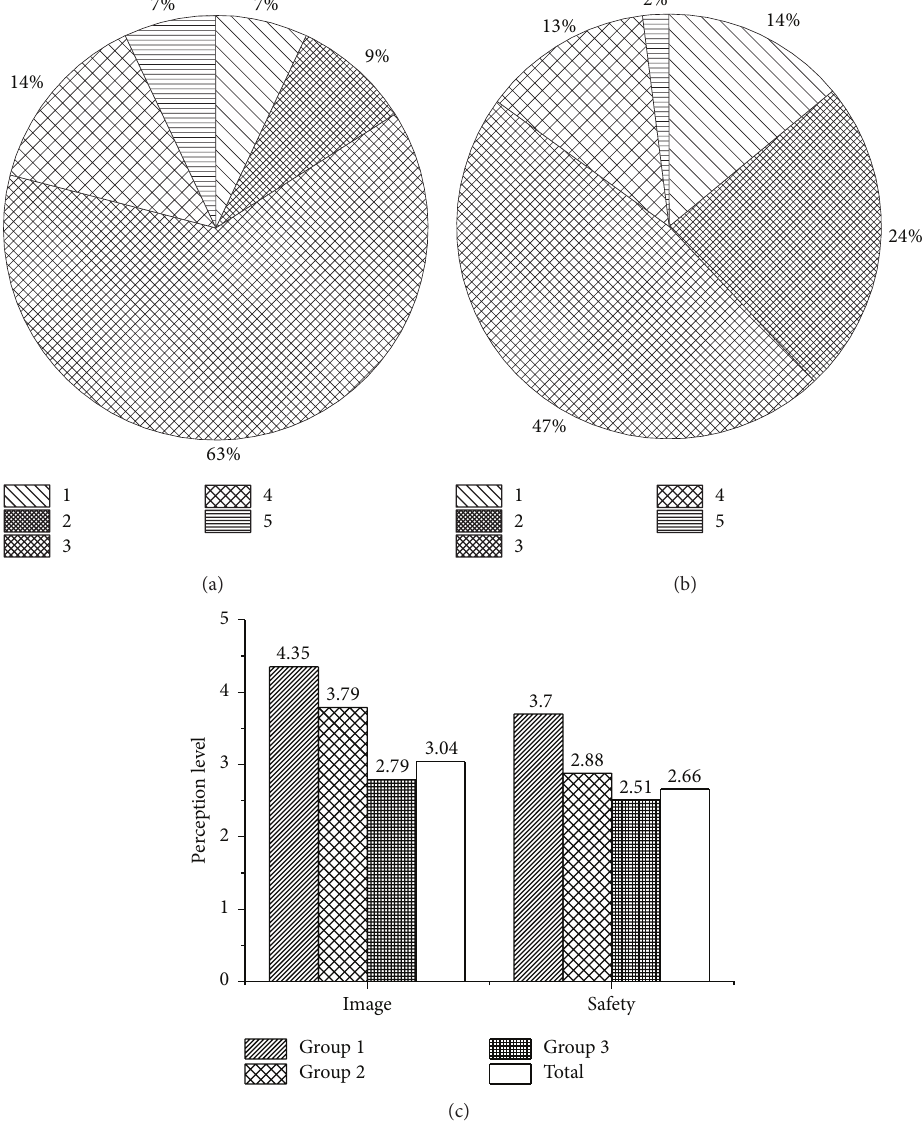
Figure 2: (a) Image level responses from 1 = very bad image to 5 = very good image, (b) safety level responses from 1 = highly unsafe to 5 = highly safe, and (c) average levels of image and safety according to